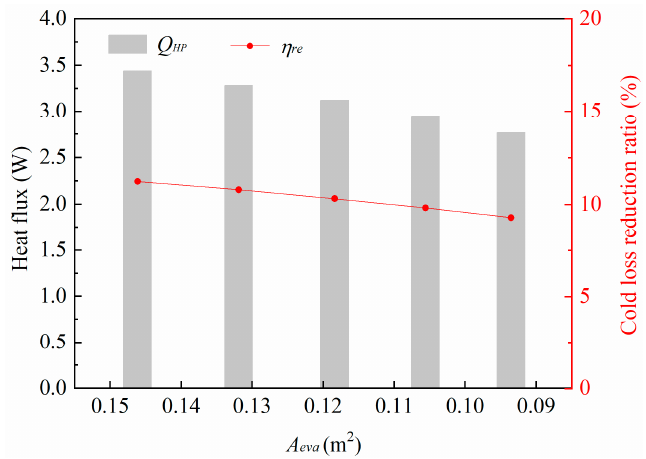
Figure 13. Behaviors of improved refrigerator versus at various A eva .